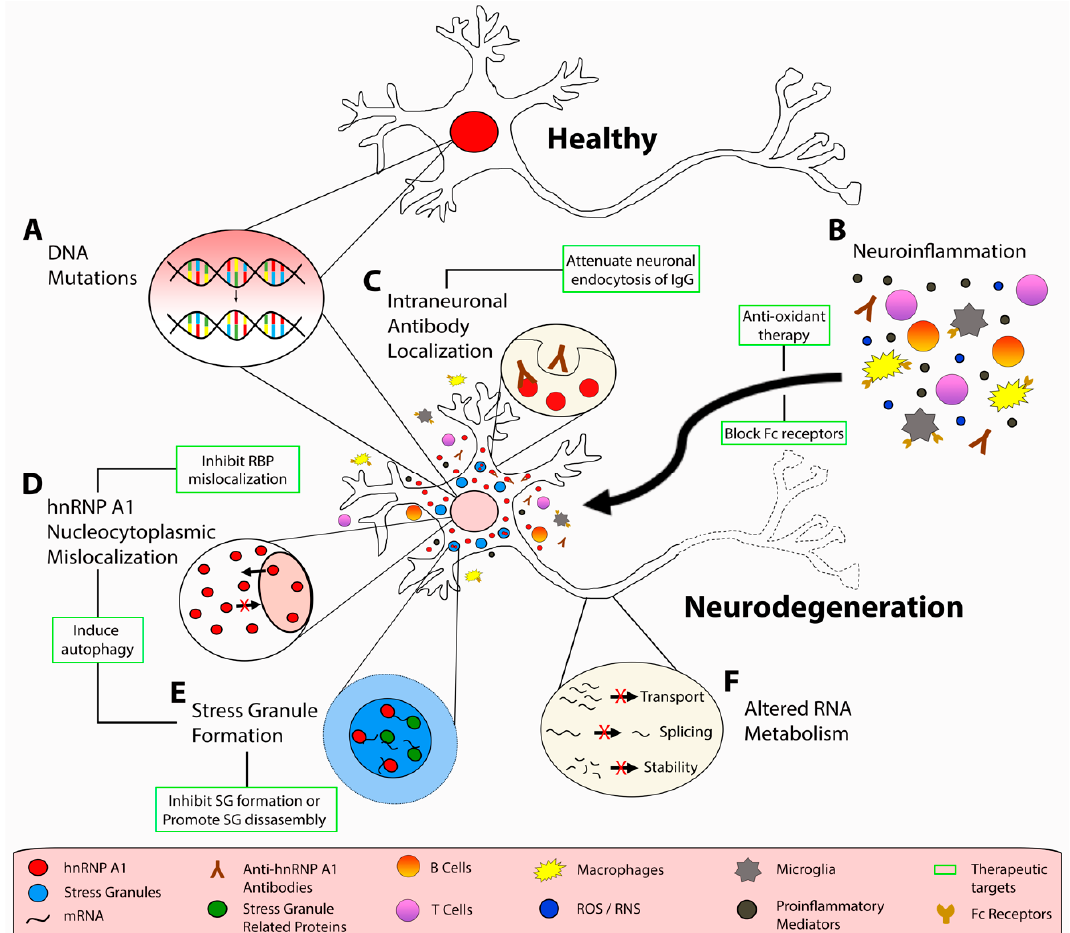
Figure 1. Potential pathogenic mechanisms of neurodegeneration in multiple sclerosis (MS). Under, homeostatic conditions, hnRNP A1 (red) is localized to the nucleus of neuronal cell bodies. In response to ( A ) genetic mutations, ( B ) neuroinflammation and corresponding proinflammatory mediators, oxidative stressors, and ( B , C ) autoantibodies, neuronal cell bodies display dysfunctional hnRNP A1 biology, including ( D ) hnRNP A1 nucleocytoplasmic mislocalization, ( E ) stress granule formation, and ( F ) altered RNA metabolism. A number of therapeutic strategies have been identified, which may prevent dysfunctional RBP-mediated neurodegeneration. These strategies include using ( B ) antioxidant and / or Fc blocking therapies, ( C ) altering neuronal endocytosis of IgG, ( D ) inhibition of RBP mislocalization, ( E ) inhibition of SG assembly or inducing SG disassembly, ( D , E ) and inducing